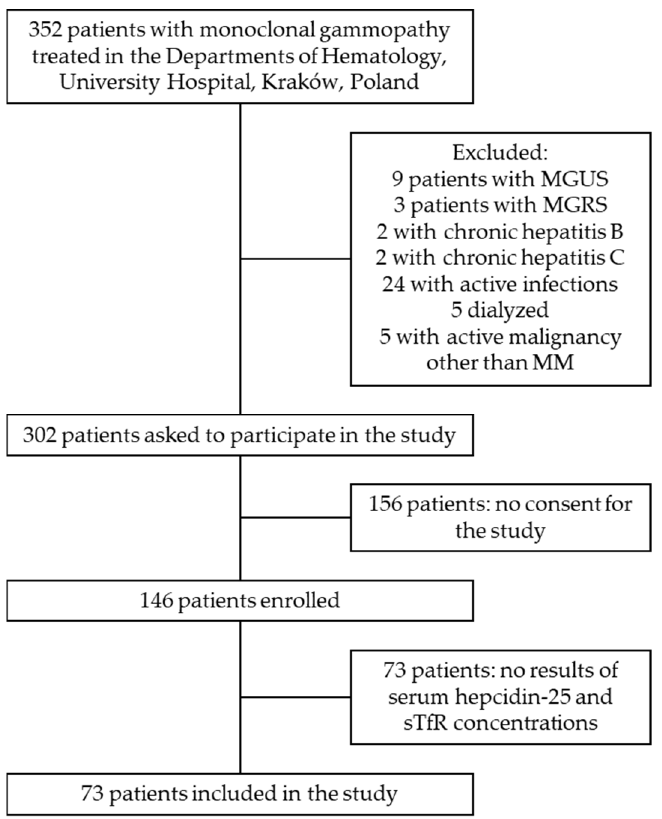
Figure 1. Flow diagram of study patient selection. Table 1. Baseline demographic and clinical characteristics of studied patients with multiple myeloma (MM) with and without anemia.